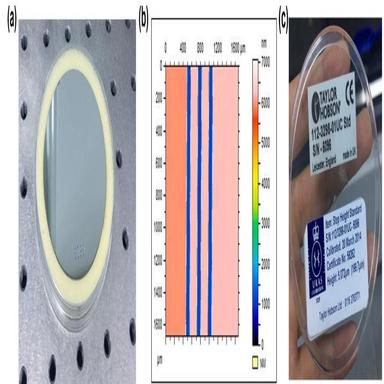
The step height standard provided by Taylor Hobson Ltd: (a) The photograph of the artefact; (b) The Micro-amplification of the surface with a 20X objective; (c) The information of the standard.